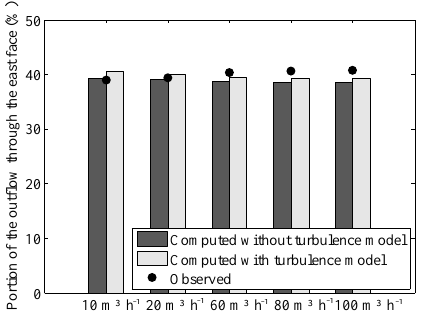
Figure 2. Distribution of outflows between the downstream faces in the observations and for different model